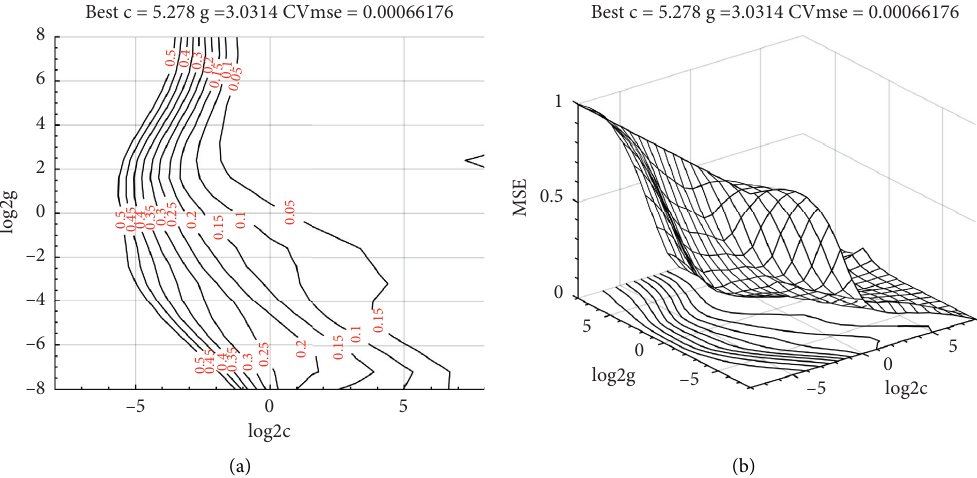
Figure 2: (a) Fine choosing results of c and g (contour diagram). (b) Fine choosing results of c and g (3D diagram).